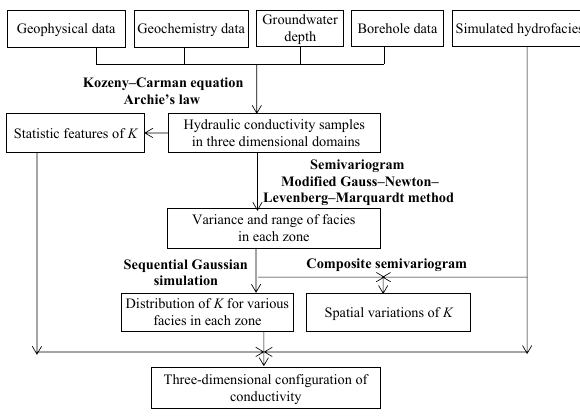
Figure 2. Flowchart of the geostatistical